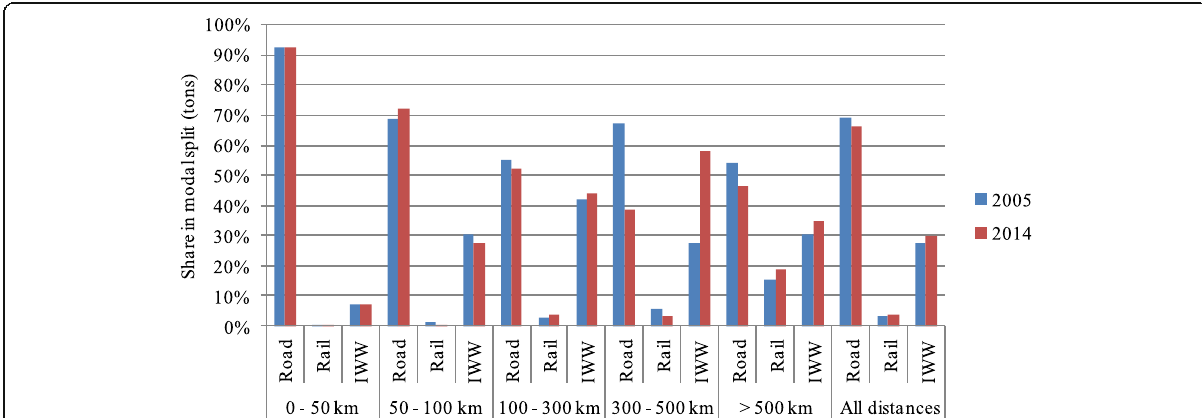
Fig. 1 Modal split in 2005 and 2014 measured in tons transported to, from and within the Netherlands. The tons transported in containers are included. Source: Statistics Netherlands, calculations by KiM. Note: IWW = Inland